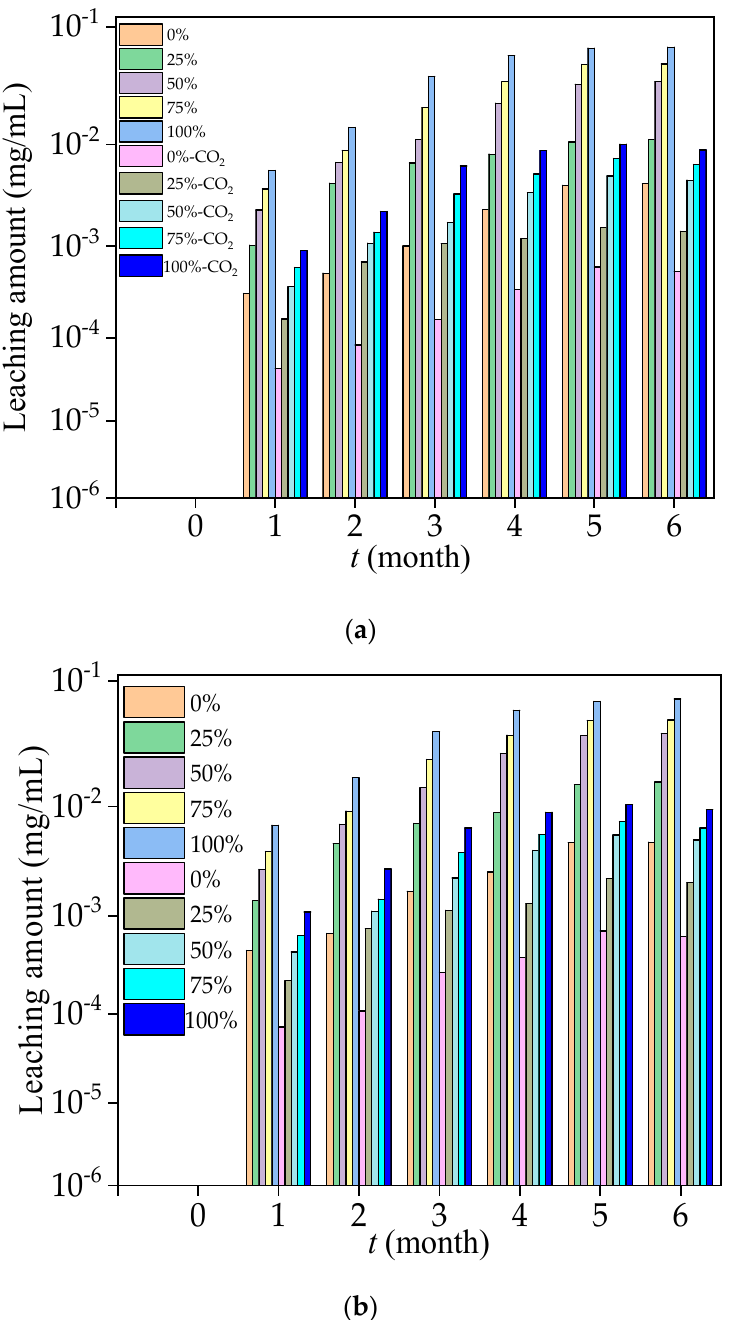
Figure 9. The leaching amount of toxic metal elements. ( a ) The leaching amount of Cr. ( b ) The leaching amount of Zn.